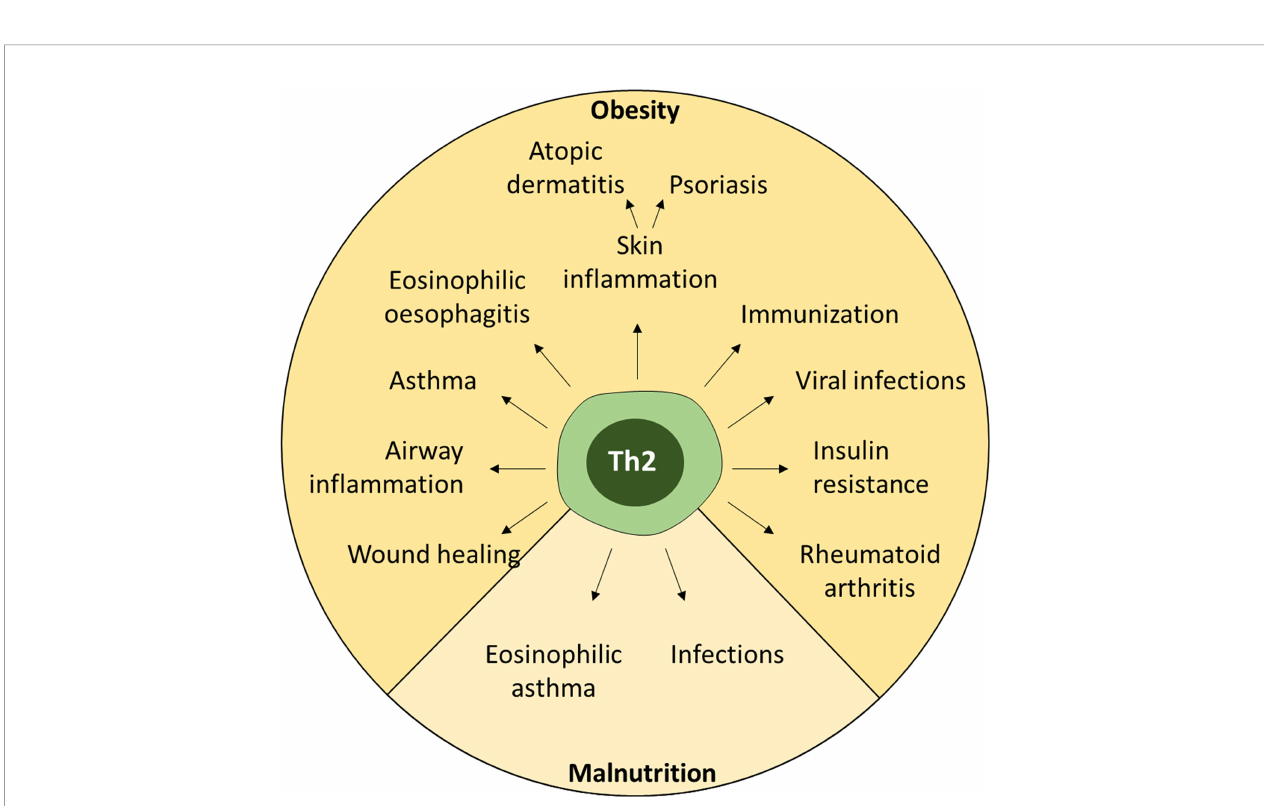
FIGURE 3 | Effects of nutritional dysregulation on peripheral immune responses. Both obesity and malnutrition lead to dysregulation of Th2 cells, which can affect many different in fl ammatory conditions ranging from allergies to infections and